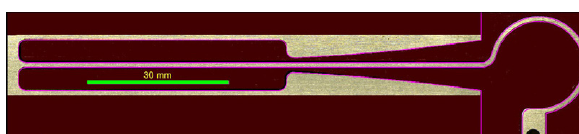
Figure 3: Waterjet nozzles.